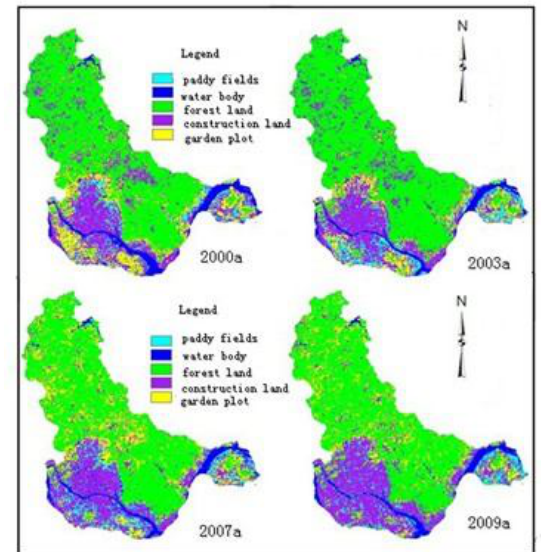
Figure10. Classified images during 2000 to 2003 to 2007 to